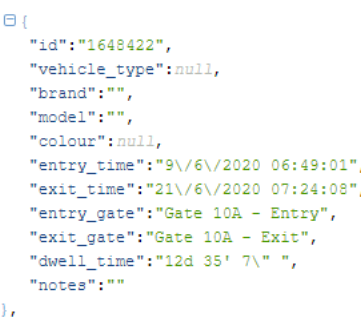
Figure 7. Data format of vehicles crossing the port gates.